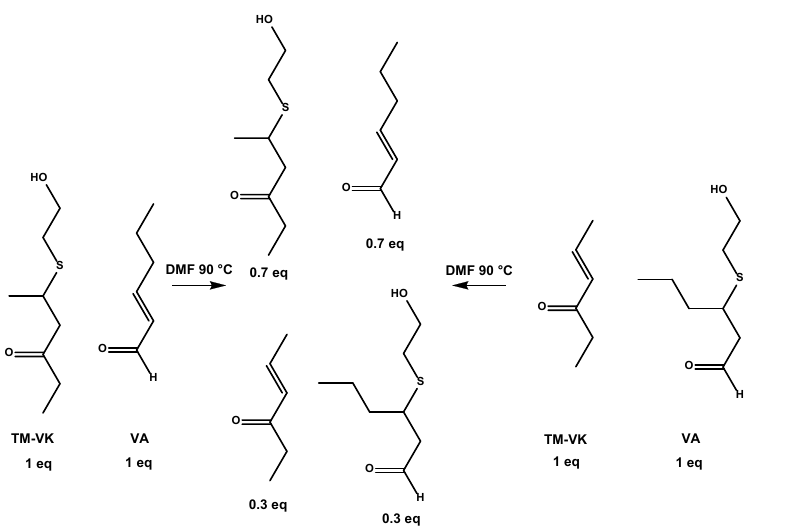
Scheme 7. Thia-Michael exchange between 4-hexen-3-one (VK) and 2-hexen-1-al (VA) and their adducts with 2-mercapoethanol (TM-VK and TM-VA, respectively).